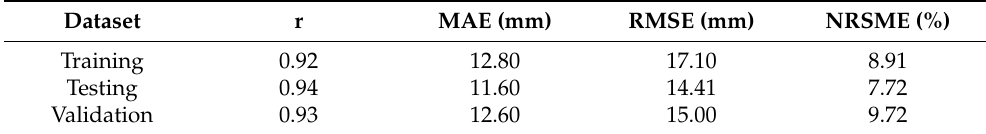
Table 2. ANN model performance measures.